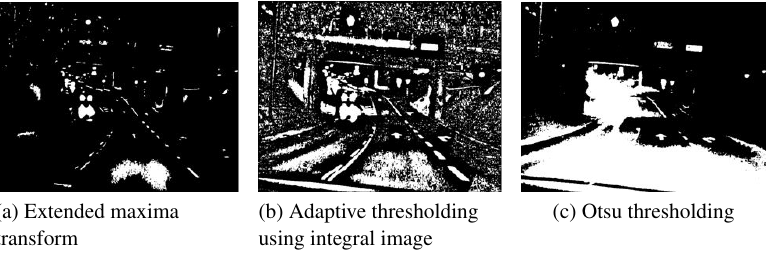
Figure 3. Comparison of different segmentation